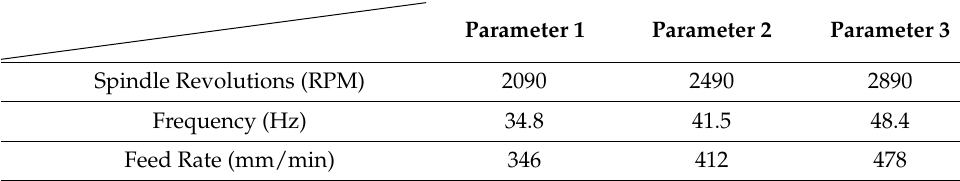
Table 10. D8 cutting parameters.